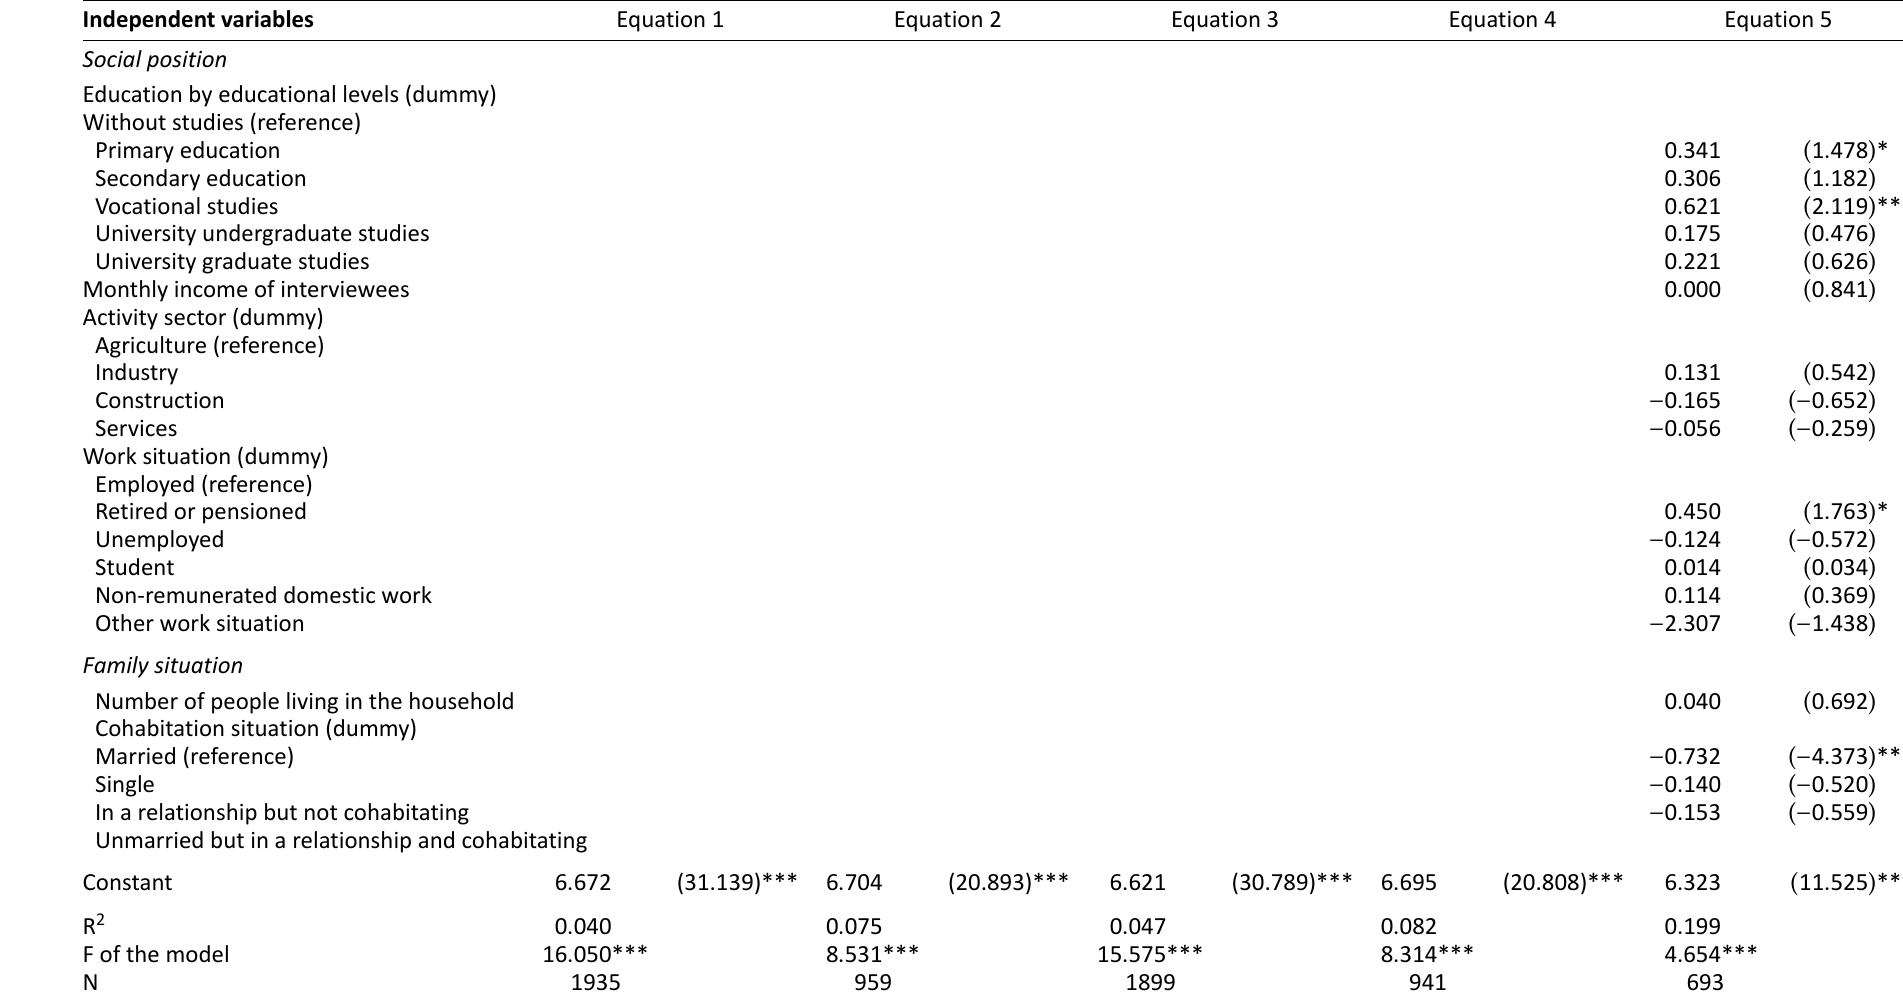
Table 4. (Cont.) Impact of personality trails and social media on subjective well‐being, OLS regression